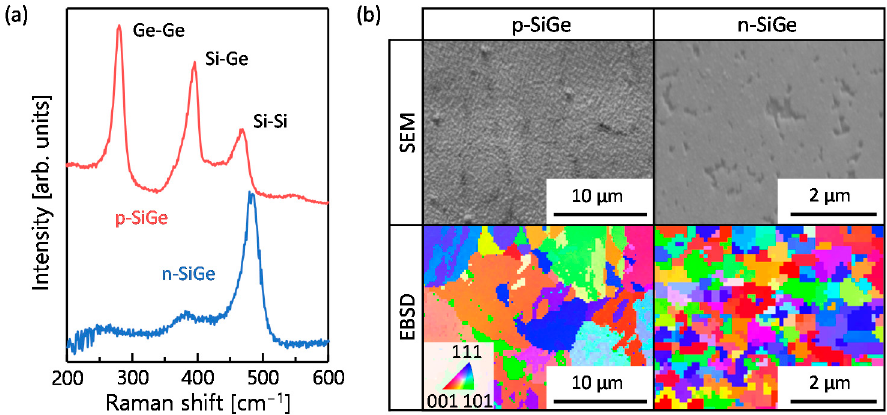
Figure 2. Characteristics of the p- and n-type samples formed by LE using Al and Ag:As, where metal layers were removed. ( a ) Raman spectra and ( b ) SEM (70 ◦ tilted) and inverse pole figure images, where colors indicate crystal orientation as shown by color key.